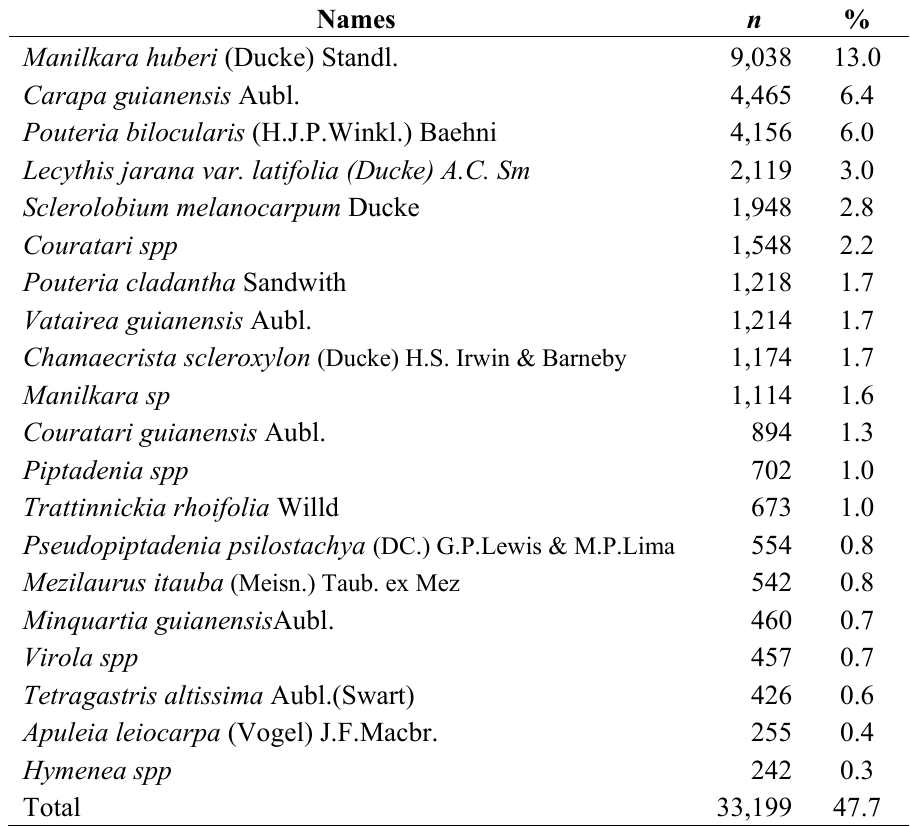
Table 3. Density and relative abundance (% of the total number of trees inventoried = 69,651) of the dominant timber species in the four Annual Production Unit; the list includes the 10 most abundant timber species in each APU.